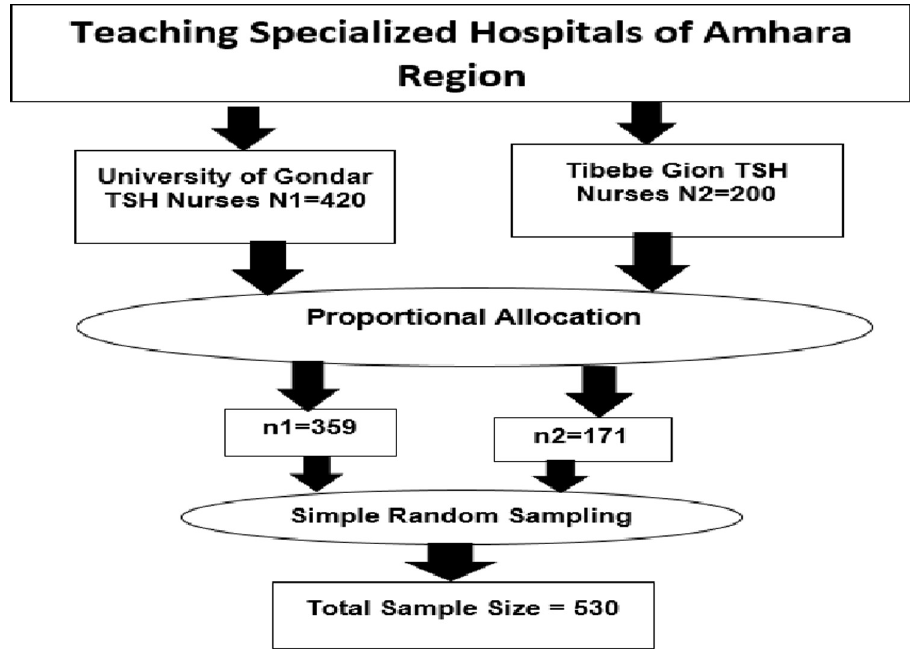
Fig 1. Sampling procedure of the study of evidence-based practice among nurses at the University of Gondar and Tibebe Gion teaching specialized hospitals, 2020.